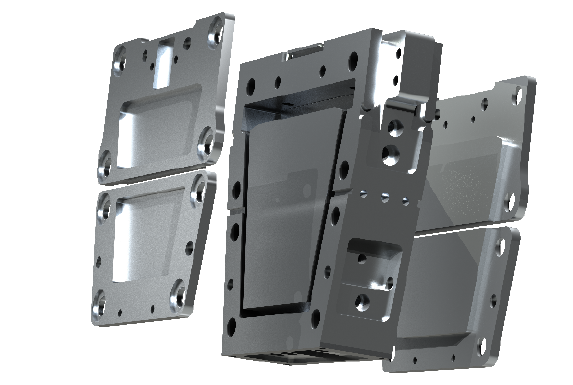
Figure 7. Rendering of a single ISA sensing element. At the center of the assembly is the sensing mass connected to the external frame and surrounded by two couples of read-out and control plates. Image courtesy of ISA BepiColombo Science Team.